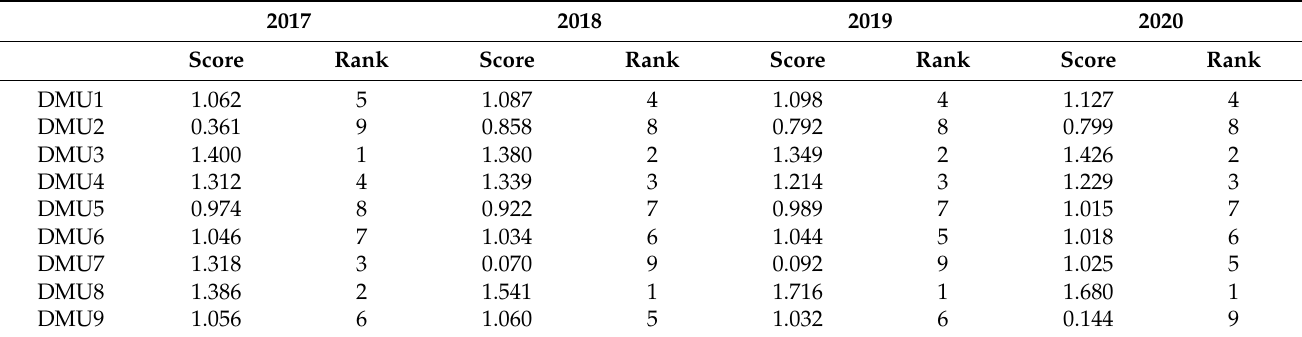
Table 2. Efficiency scores and ranks of